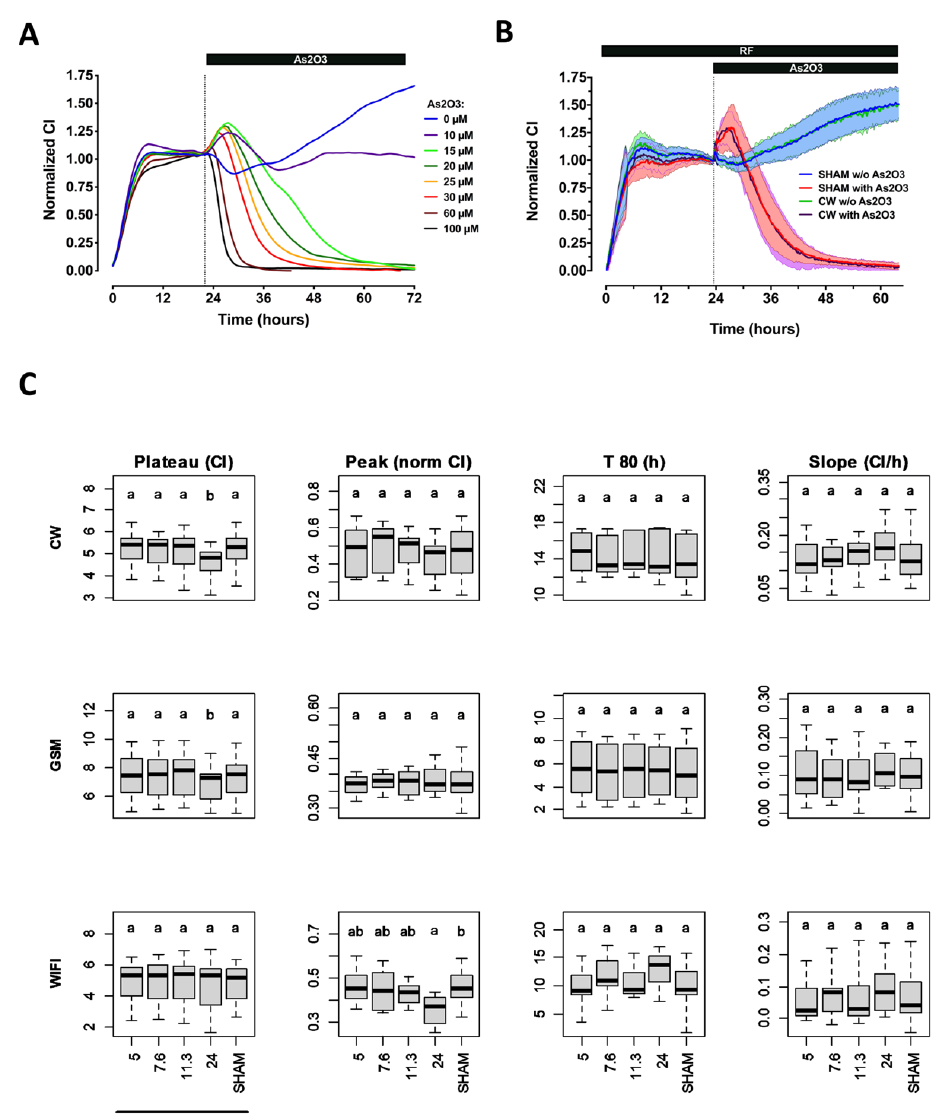
Figure 2. Characterization of the response of primary astrocytes cells under RF exposure alone or under co-exposure to RF and As 2 O 3 . ( A ) Characterization of the CI temporal signature of primary rat astrocytes cells challenged with increasing concentrations of As 2 O 3 . The vertical dashed line indicates the time at which cells were either mock-challenged or challenged with the indicated concentration of As 2 O 3 . The data represent the average of three independent experiments. For better clarity, the measurement error is not represented. ( B ) Example of the normalized CI temporal signature recorded from primary astrocytes cell cultures that were either sham-exposed or exposed to unmodulated 1800 MHz (CW signal) at 24 W/kg. The vertical dashed line indicates when cells were either mock-challenged or challenged with 30 µ M As 2 O 3 . The data represent the average of 9 to 11 independent experiments ± SEM values. ( C ) Statistical analysis of the effect of CW, GSM, and Wi-Fi-modulated 1800 MHz signals emitted at 5, 7.6, 11.3, or 24 W/kg on four metrics describing primary astrocyte cells impedance measurement in presence or absence of As 2 O 3 . First left column: average CI measured during the 5 h preceding injection of As 2 O 3 or buffer. Second column to the left: magnitude of the CI increase in response to As 2 O 3 . Third column to the left: time at which 80% of the cell population died following As 2 O 3 injection. Last column on the right: cell proliferation rate at day 3 in the absence of As 2 O 3 . The number of replicates per condition is indicated in Supplementary Table